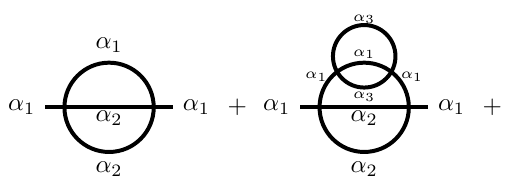
Figure 1. Contributions to two point function self